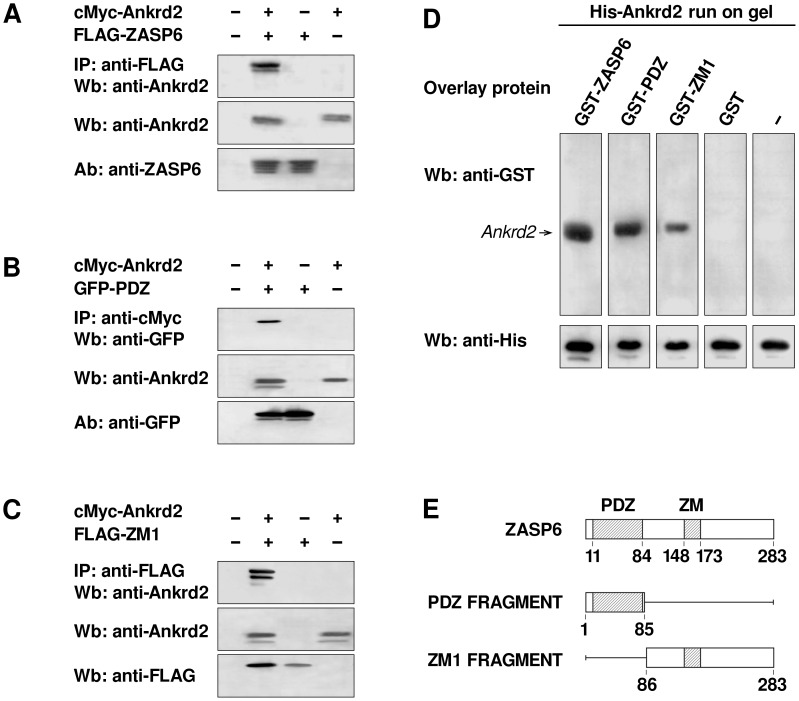
PDZ and ZM1 regions of ZASP6 directly bind Ankrd2.
A) Co-IP of ZASP6 and Ankrd2 using lysates of COS-7 cells transfected with the indicated combination of pCMV vectors expressing cMyc-Ankrd2 and FLAG-ZASP6. Immunoprecipitation was performed with anti-FLAG antibody. The presence of Ankrd2 in the immune complex was confirmed by probing the membrane with mouse polyclonal anti-Ankrd2 antibody (upper panel). As controls, the cell lysates were tested with polyclonal antibodies to anti-Ankrd2 (middle panel) and anti-ZASP6 (bottom panel). B) Co-IP of PDZ-ZASP6 and Ankrd2 using lysates of COS-7 cells transfected with cMyc-Ankrd2 and pEGFP-PDZ as indicated. The cell lysates were immunoprecipitated with an anti-cMyc monoclonal antibody and probed with a polyclonal goat anti-GFP antibody conjugated to HRP (upper panel). Comparable expression levels of Ankrd2 and PDZ-ZASP6, weredemonstrated by probing the membrane with a mouse anti-Ankrd2 polyclonal antibody (middle panel) and rabbit anti-GFP polyclonal antibody (lower panel). C) Co-IP of ZM1-ZASP6 and Ankrd2 using lysates of COS-7 cells transfected with cMyc-Ankrd2 and FLAG-ZM1 as indicated. Ankrd2 was immunoprecipitated with anti-FLAG EZview resin and detected with an anti-Ankrd2 mouse polyclonal antibody (upper panel). As controls, cell lysates were tested with an anti-Ankrd2 mouse polyclonal antibody (middle panel) and with an anti-FLAG rabbit polyclonal antibody (bottom panel). All secondary antibodies were conjugated with HRP. D) GST-overlay assay with purified recombinant proteins expressed in E. coli. His-Ankrd2 (4 μg) was separated by SDS-PAGE, blotted and membrane strips were incubated with 4 μg of either GST-ZASP6, GST-PDZ, GST-ZM1 or GST alone, washed and then probed with anti-GST goat polyclonal antibody. As a control, an anti-histidine antibody was used to probe membrane strips identical to those used for the overlay to show that the His-Ankrd2 protein was equally loaded (lower panel). E) A schematic diagram of ZASP6 showing the positions of the PDZ domain (aa 11–84) and ZM-motif (aa 148–173). In this study the expression vectors with constructs for PDZ and ZM1 (ZASP6 without the PDZ domain) expressed respectively 85 and 197 amino acid fragments of ZASP6.